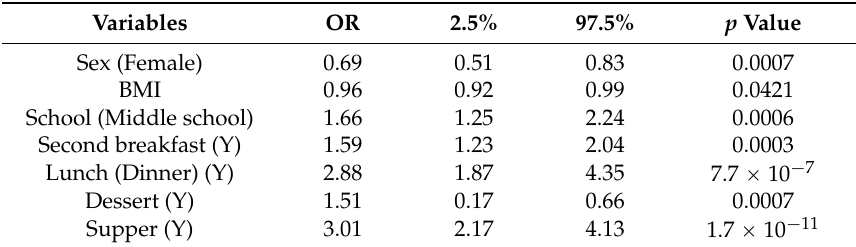
Table 4. Adjusted odds ratios for breakfast consumption with regard to sex, BMI, age (expressed as level of education) and other meals